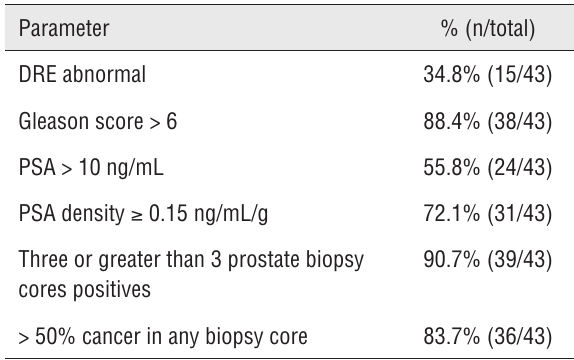
Table 2 - Characteristics of the 43 patients with sPCa. ª